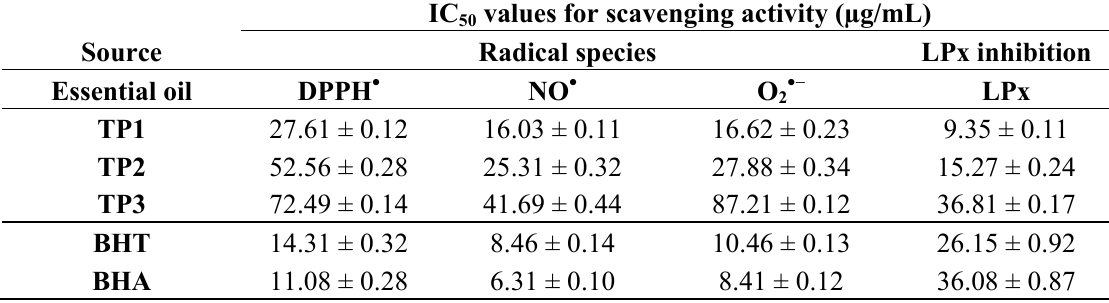
Table 2. IC values for evaluated antioxidant assays of examined Trifolium pratense 50 essential oil, BHT and